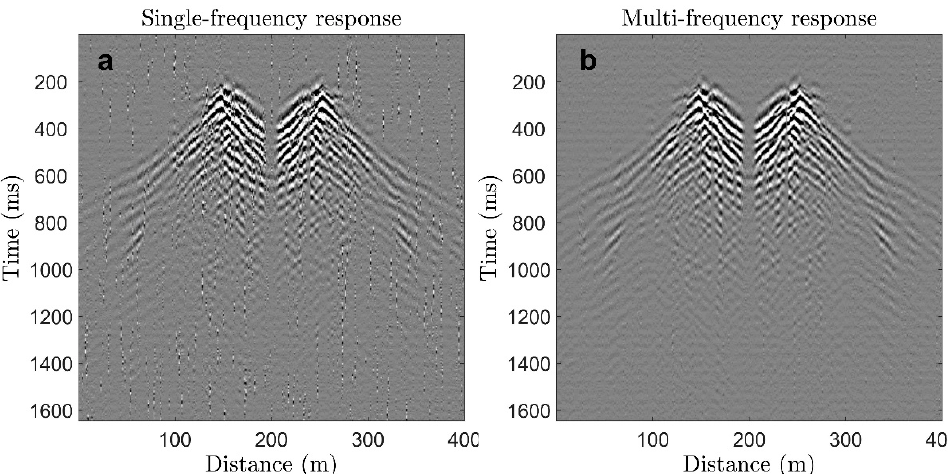
Figure 4. The DAS response in space-time domain at a single interrogation frequency ( a ), and averaged over 16 interrogation frequencies ( b ). The mirror symmetry is due to the fact that the two fibers in the cable were spliced at the end of the cable. Grayscale shows the amplitude of seismic waves in arbitrary units. The record starts approximately 200 ms prior to the load hitting the ground.